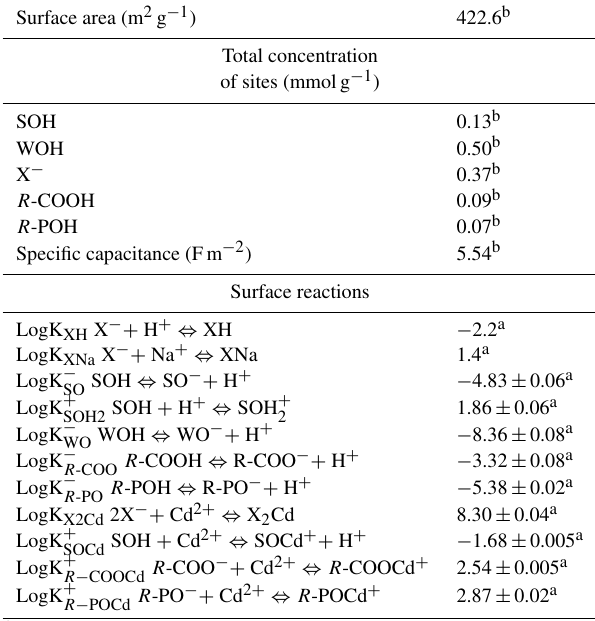
Table 1. Surface complexation model parameters for Cd(II) sorp- tion on montmorillonite– B. subtilis